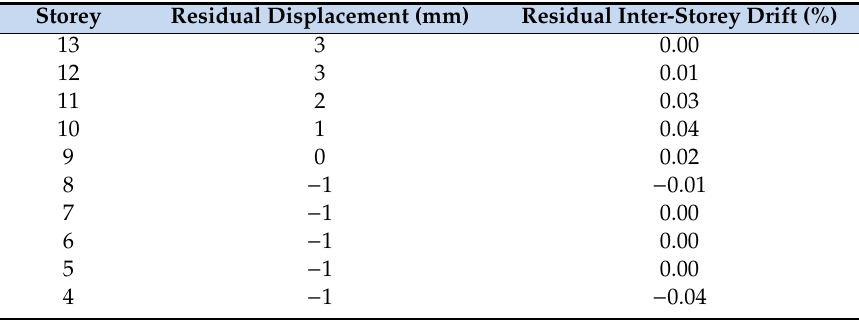
Table 8. The THC residual displacement and inter-storey drift for the ULS case. Storey Residual Displacement (mm) Residual Inter-Storey Drift